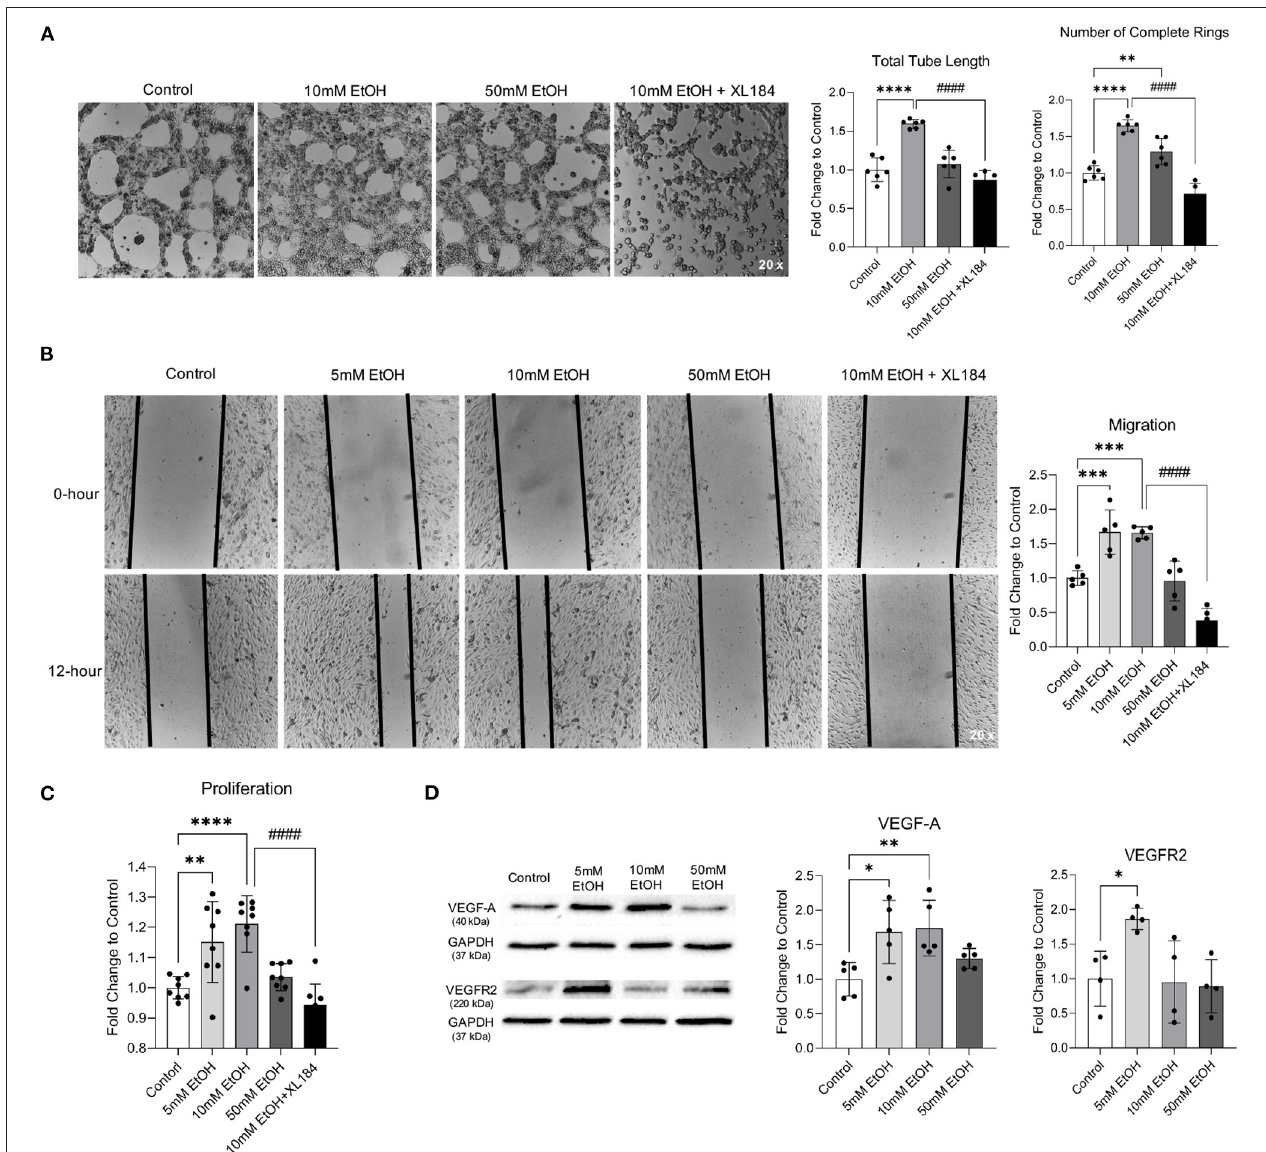
FIGURE 1 | Effect of acute alcohol exposure on tube formation, migration, proliferation, and expression of VEGF-A and VEGFR2 in MBMVECs. (A) Representative images of tube formation (left). Values are means ± SD (right, n = 6). (B) Representative images (left) of migration. Values are means ± SD (right, n = 5). (C) Values are means ± SD ( n = 8) for proliferation. (D) Representative Western blots of VEGF-A and VEGFR2 (left). Values are means ± SD (right, n = 4–5). * P < 0.05, ** P < 0.005, *** P < 0.0005, **** P < 0.0001 vs. Control. #### P < 0.0001 vs. 10mM EtOH. Analyzed using one-way ANOVA with Dunnett’s post-hoc